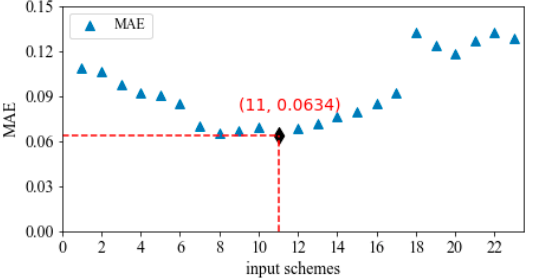
Figure 4. Results of 23 input schemes obtained from reanalysis data.